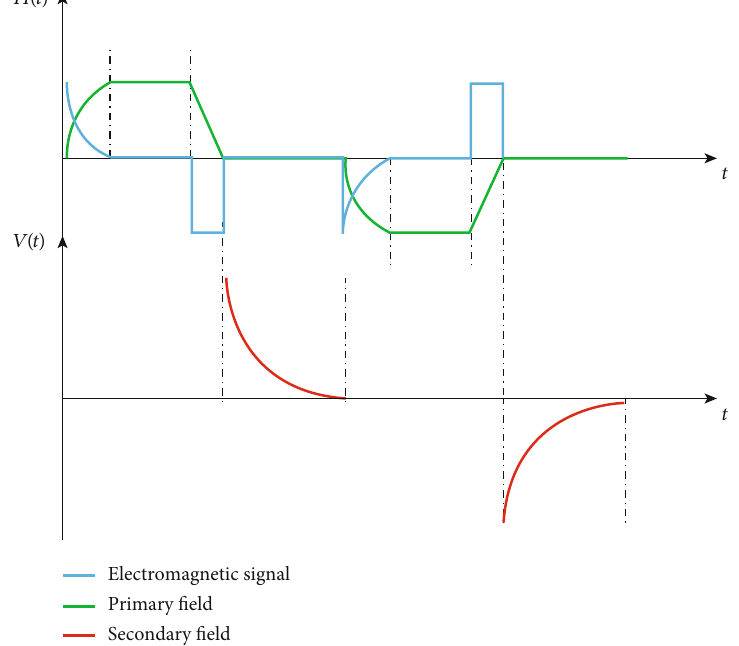
Figure 2: Schematic diagram of transient electromagnetic signal. V ð T Þ is induced voltage; H ð t Þ is magnetic fi eld